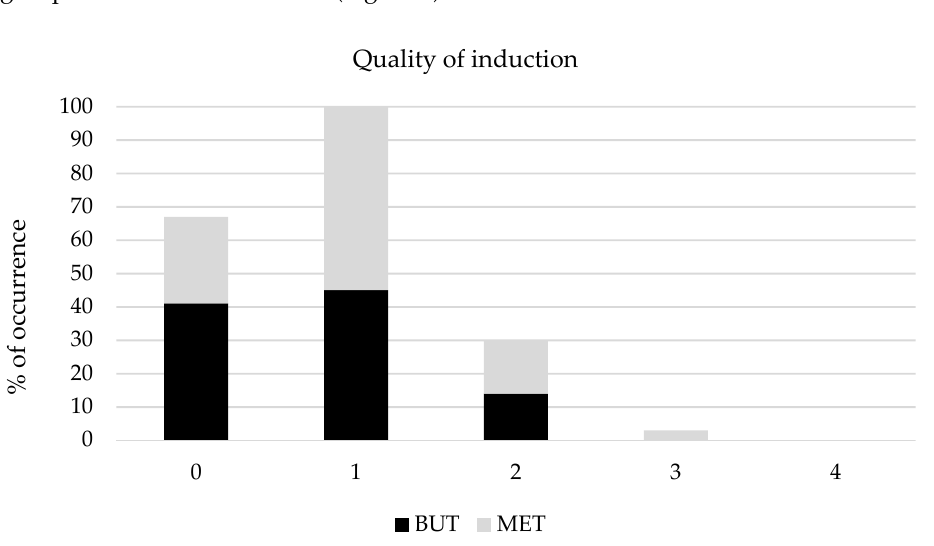
Figure 2. Occurrence of scores for induction quality assigned to horses receiving romifidine and either butorphanol (group BUT, n = 29) or methadone (group MET, n = 31). 0 = excellent, 1 = good, 2 = adequate, 3 = fair, 4 = poor.